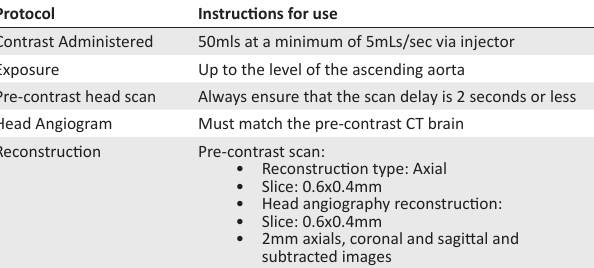
TABLE 1: Protocol used for conducting computed tomography angiography and image reconstruction